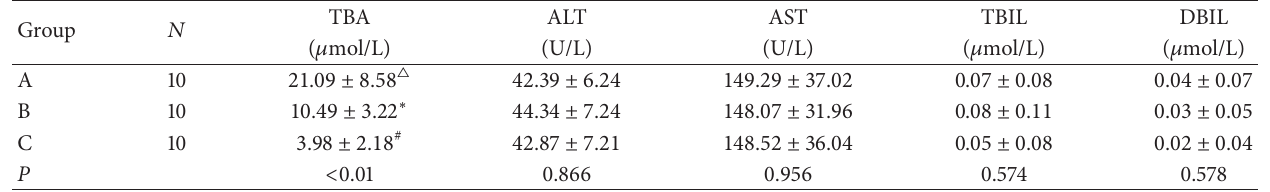
Table 2: Comparison of biochemical indicator levels in maternal serum of three groups after intervention ( 𝑥 ± s ).